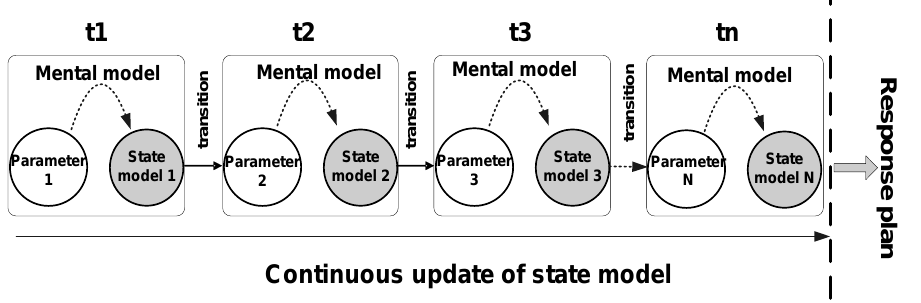
Figure 4. Interaction process between monitoring and state evaluation.